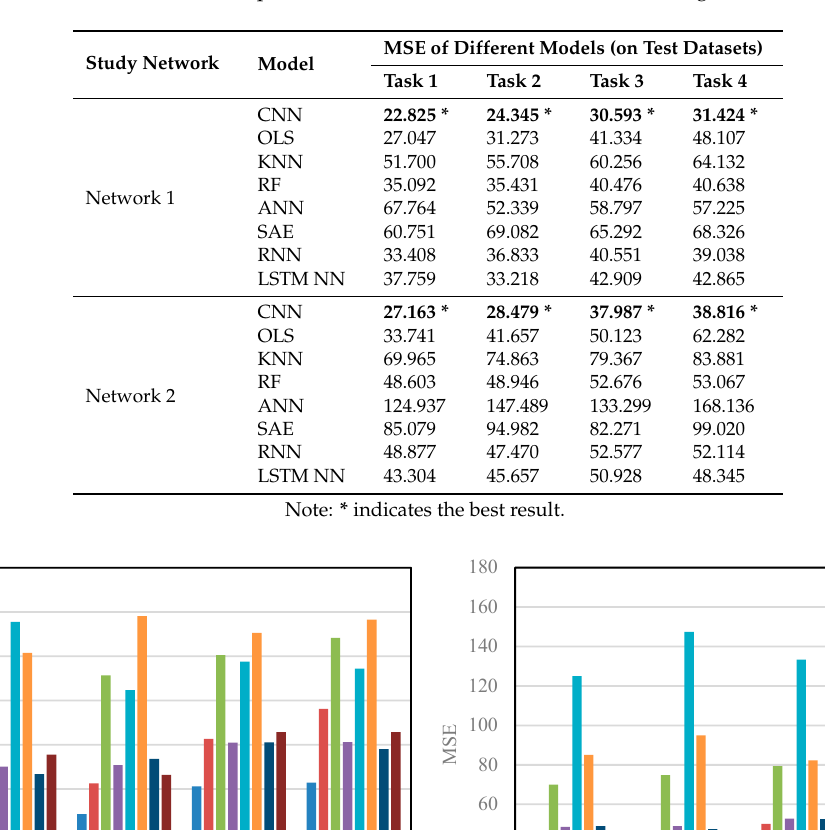
Table 3. Prediction performance (MSE) of the CNN and other algorithms.